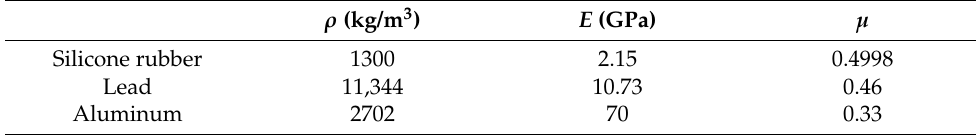
Figure 2. Geometric parameters of the HPFC. ( a ) A three-dimensional schematic diagram of the hollow cylindrical plate. There is a hollow pillar placed on the thin plate; ( b ) 3D schematic diagram of filling pillar; ( c ) the integral part of the assembly; ( d ) the first irreducible Brillouin zone of the square lattice. Table 1. Physical properties of silicone rubber, lead, and aluminum